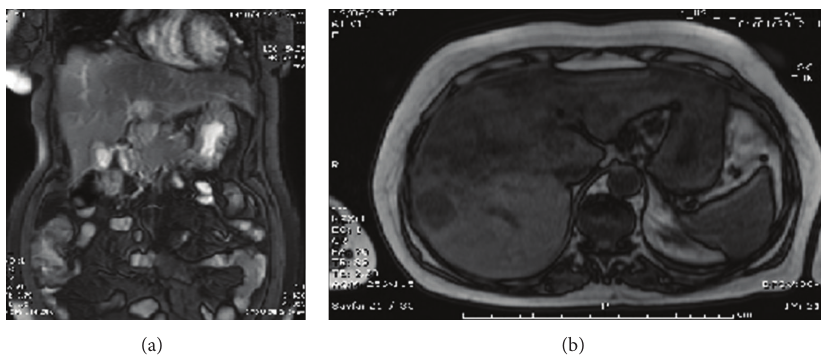
Figure 4: Coronal and axial images from control